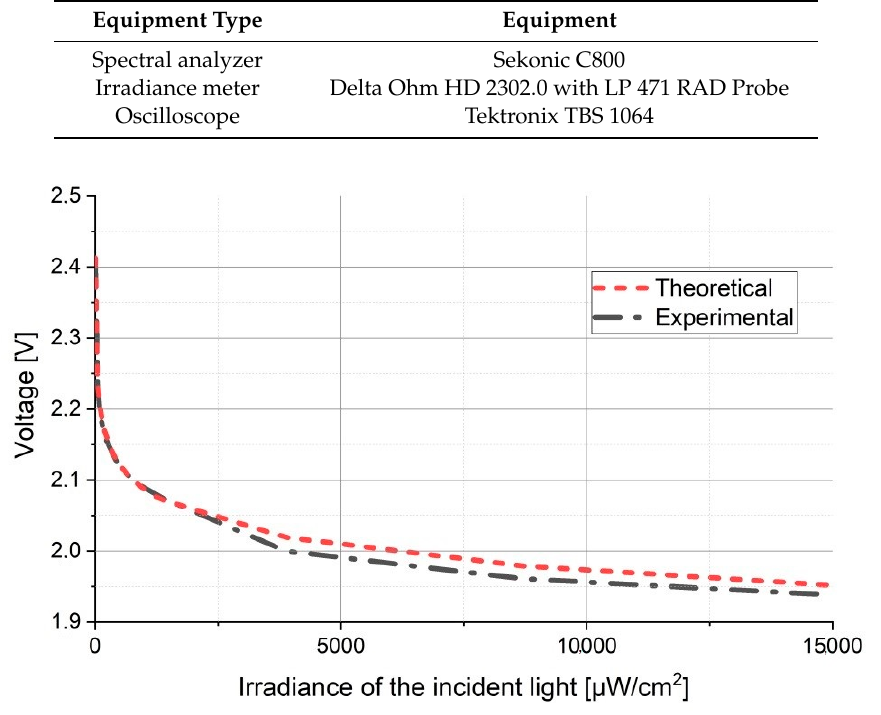
Figure 4. Experimental evaluation of the logarithmic transimpedance circuit ability to mitigate photoelement saturation. The graphic illustrates the circuit’s response to an increasing incident light. One can see that although the incident irradiance reached 15,000 µ W / cm 2 , the circuit still responds to changes in light